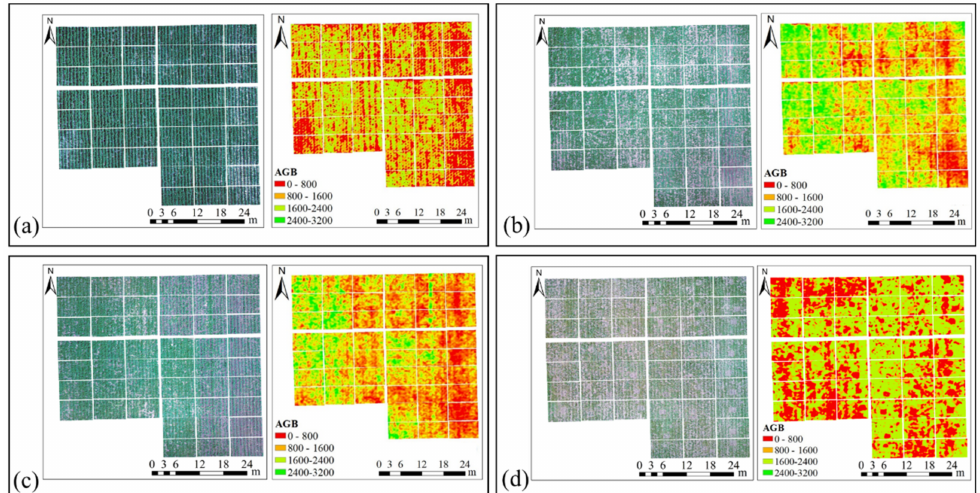
Figure 8. RGB images of potato canopy (left) and distribution (right) of the estimated AGB (kg/hm 2 ) in the 48 study plots obtained by combining VIs and the optimal GEPs and using the PLSR method: ( a ) tuber formation, ( b ) tuber growth, ( c ) starch storage, ( d )